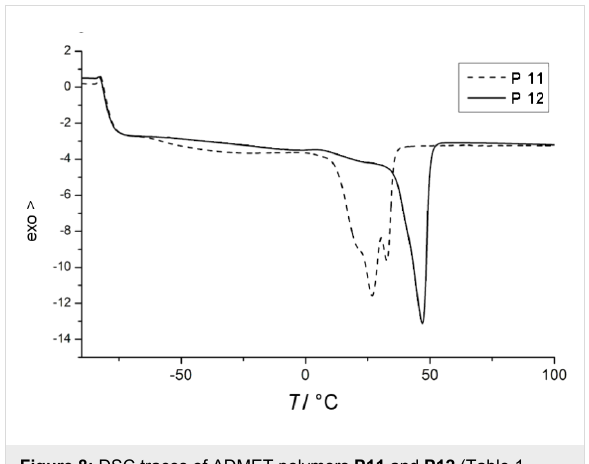
Figure 8: DSC traces of ADMET polymers P11 and P12 (Table 1, entries 11 and 12,